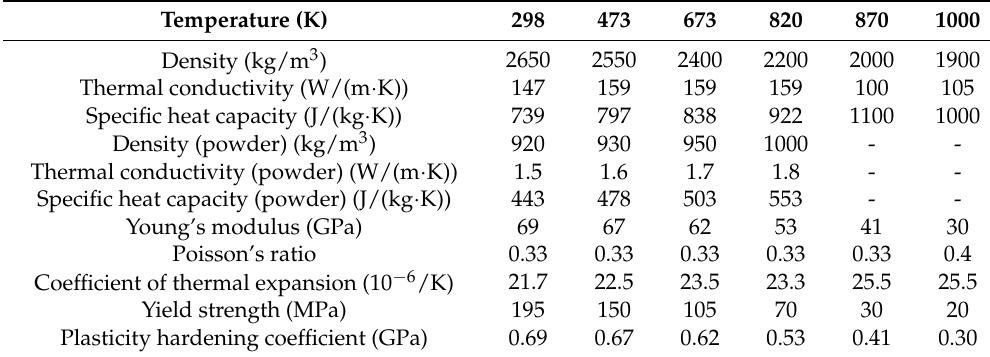
Table 2. Temperature-independent properties of AlSi10Mg alloy [22,25].